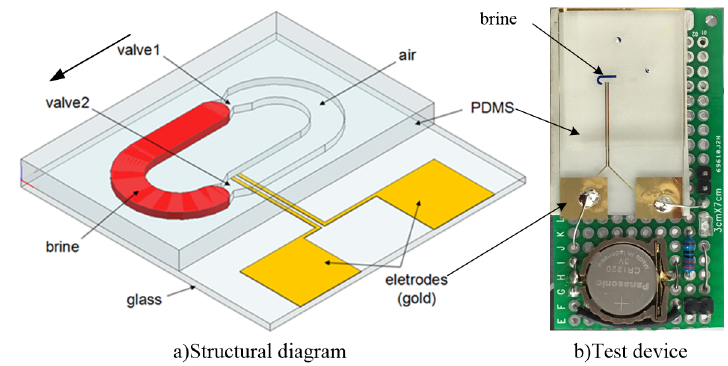
Figure 1. The designed U-type microfluidics inertial switch.